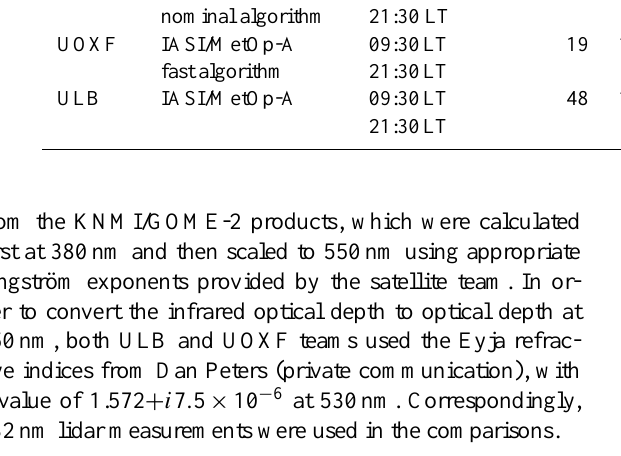
Table 2. Collocation criteria examined in the EARLINET–satellite comparisons. Institute Satellite product Overpass Amount of Collocation Number of Comments time data in days criteria coincidences KNMI GOME-2/MetOp-A 09:30LT 14 3h and 300km 12 IASI/MetOp-A 09:30LT nominal algorithm 21:30 LT IASI/MetOp-A 09:30LT 3 fixed heights provided, fast algorithm 21:30LT 400, 600 and 800hPa IASI/MetOp-A 09:30LT